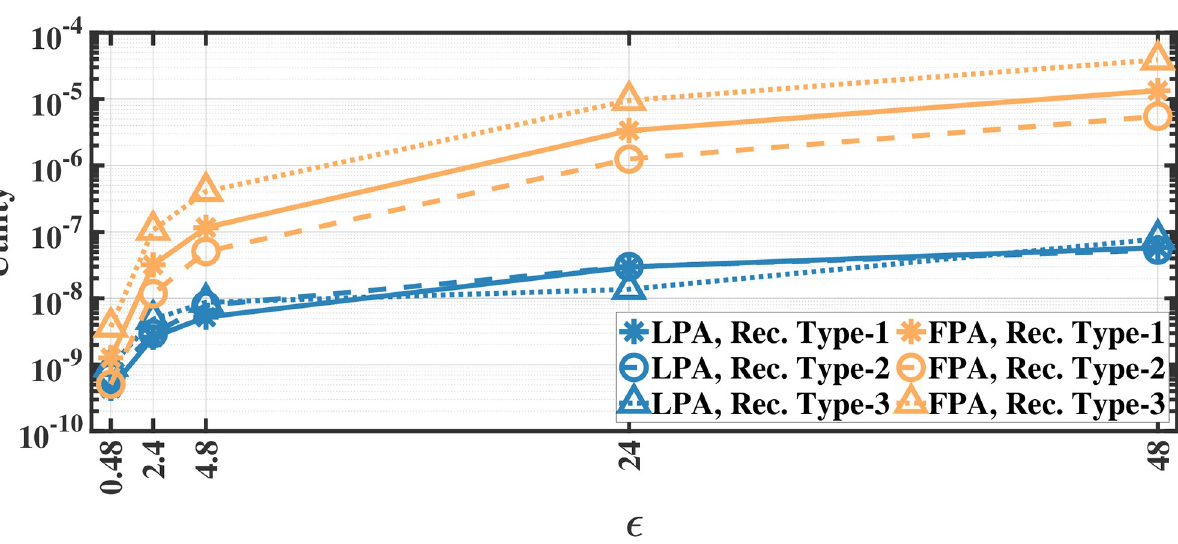
Fig 10. Utility of the LPA and FPA for